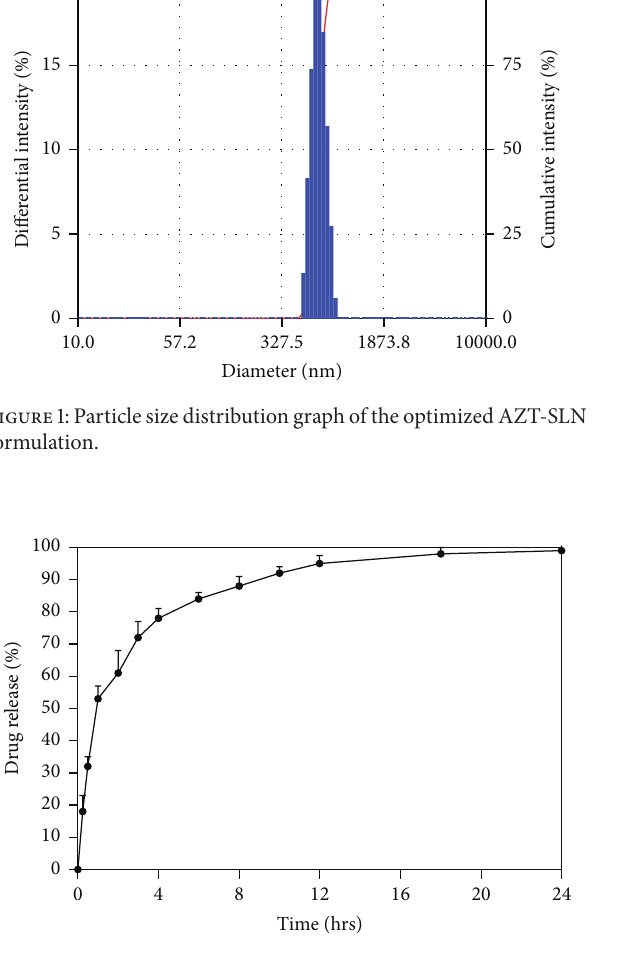
Figure 2: In vitro release of the optimized AZT-SLN formulation.